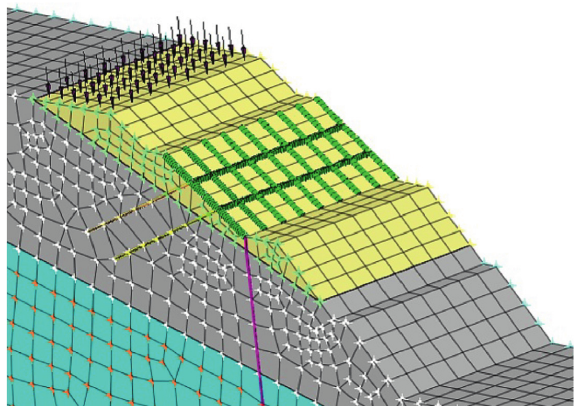
Figure 6: The dynamic model of slope time-history analysis